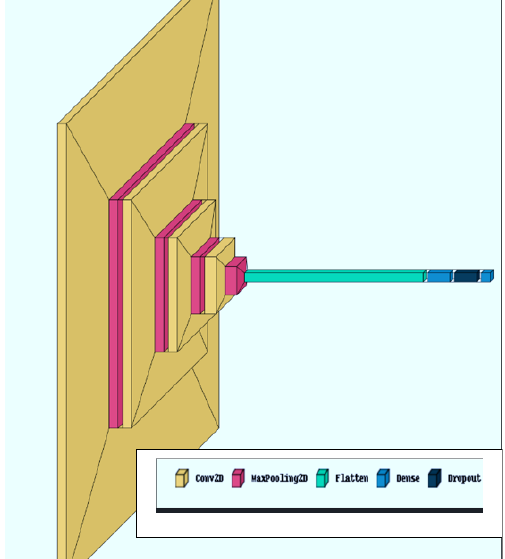
Figure 14. Model with dropout layer.